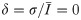
Amplitude of the oscillations of the mean membrane potential for a population of N = 1000 WB neurons.From left to right: δ=σ/I¯=0, 0.05 and 0.06. Central and Right panels have σ = 0.01 μA/cm2. See Materials and methods for details.